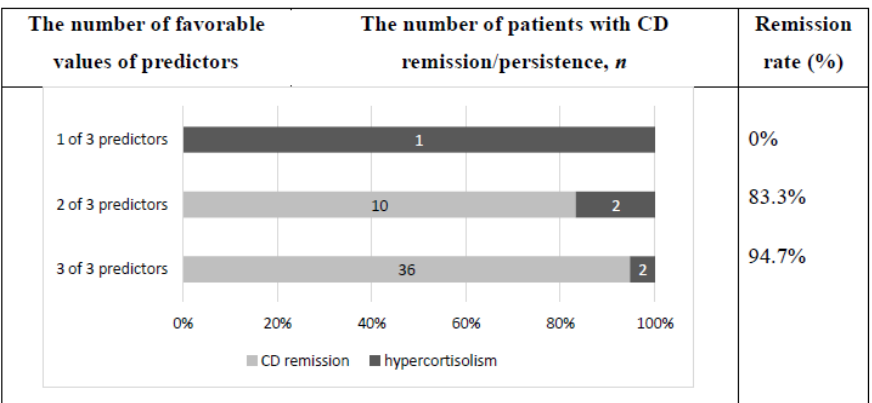
Figure 5. Remission rate after TSS depending on the number of favorable values of predictors of CD remission after surgery (long-term follow-up).